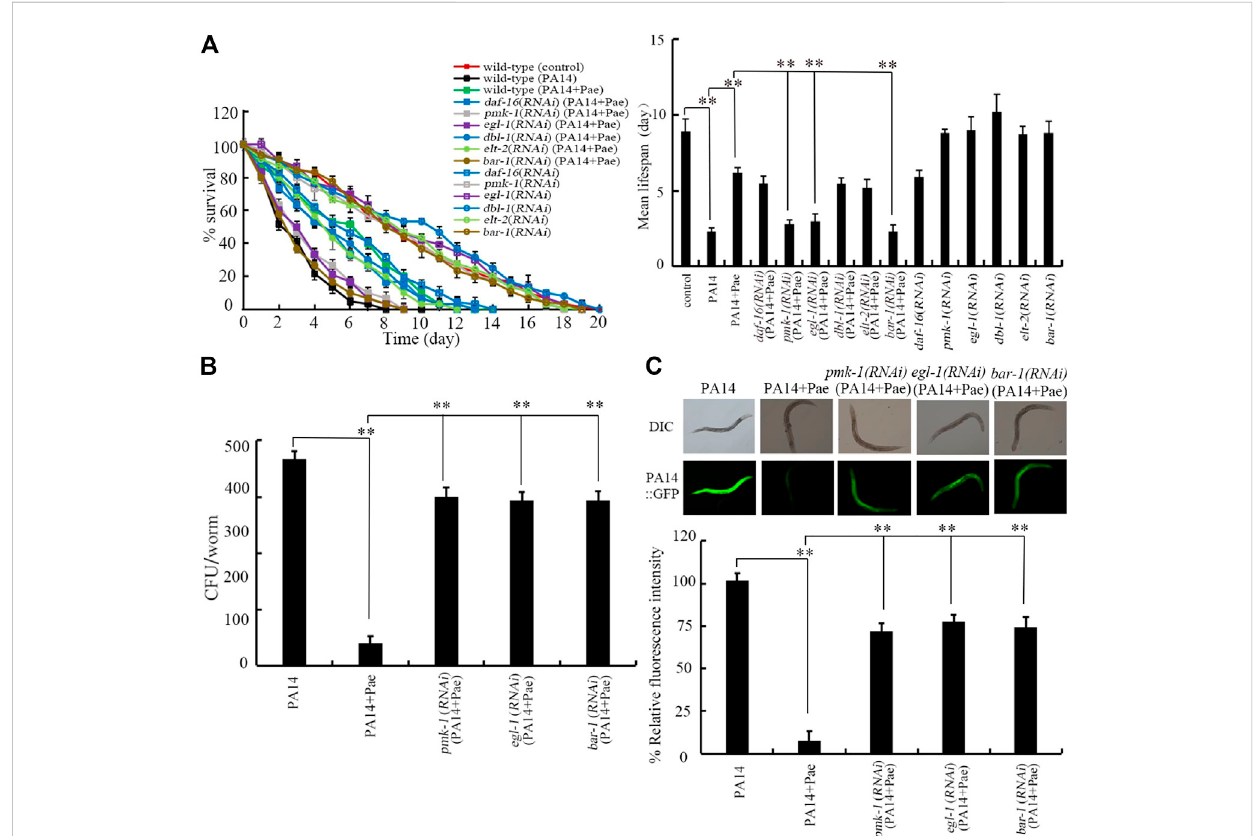
FIGURE 3 Effect of bar-1 , elt-2 , pmk-1 , dbl-1 , egl-1 , and daf-16 RNAi on bene fi cial role of 10 mg/L paeoni fl orin in nematodes after the bacterial infection. (A) Effect of bar-1 , elt-2 , pmk-1 , dbl-1 , egl-1 , and daf-16 RNAi on bene fi cial role of paeoni fl orin in increasing lifespan in nematodes after the bacterial infection. Lifespan curve of PA14 showed a signi fi cant difference ( p < 0.01) compared to control. Lifespan curve of PA14 + Pae showed a signi fi cant difference( p < 0.01)comparedtoPA14.Lifespancurvesof pmk-1 ( RNAi )(PA14+Pae), egl-1 ( RNAi )(PA14+Pae),and bar-1 ( RNAi )(PA14+Pae)showed a signi fi cant difference ( p < 0.01) compared to PA14 + Pae. In contrast, the lifespan curves of daf-16 ( RNAi ) (PA14 + Pae) ( p = 0.361), dbl-1 ( RNAi ) (PA14 + Pae) ( p = 0.364), and elt-2 ( RNAi ) (PA14 + Pae) ( p = 0.332) did not show a signi fi cant difference compared to PA14 + Pae. (B) Effect of bar-1 , elt-2 , pmk-1 , dbl-1 , egl-1 , and daf-16 RNAi on bene fi cial role of paeoni fl orin in decreasing CFU of P. aeruginosa PA14 in nematodes after the bacterial infection. (C) Effect of bar-1 , elt-2 , pmk-1 , dbl-1 , egl-1 , and daf-16 RNAi on bene fi cial role of paeoni fl orin in suppressing accumulatio of P. =aeruginosa PA14:GFP